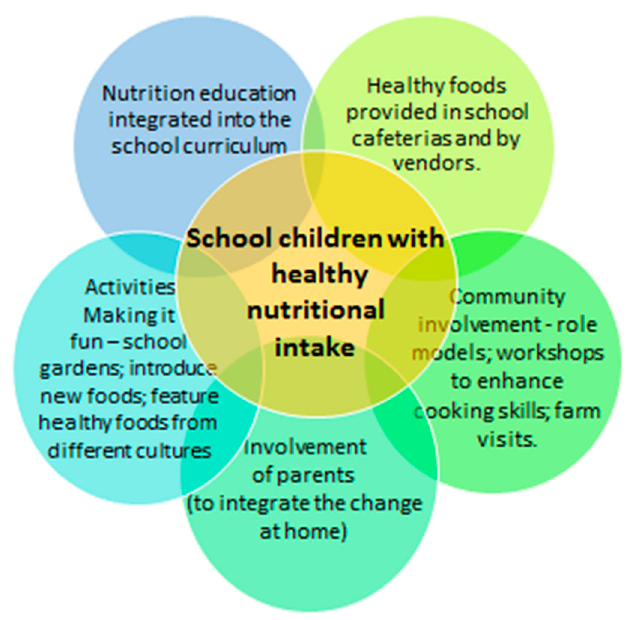
Figure 1. An integrated and comprehensive school-based approach to improve the quality of nutrition and decrease the calorie intake amongst school children (adapted from two Shaping Healthy Choices Programme webpages [44,48]).